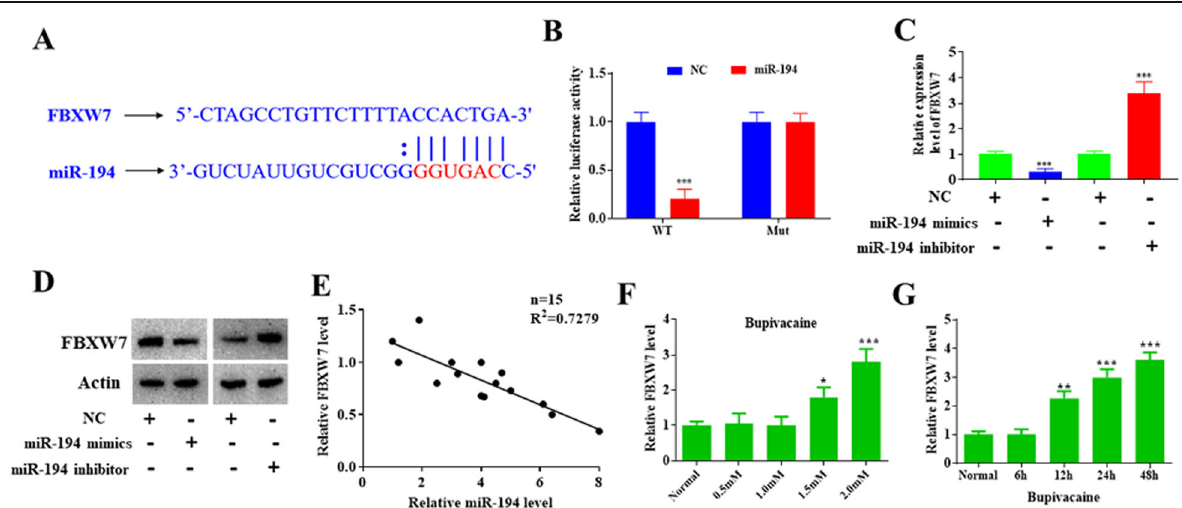
Fig. 4 FBXW7 is the direct target of miR-194. a The predicted binding sequence of the 3 ’ UTR of FBXW7 ’ s mRNA and miR-194. b The relative luciferase activity was significantly reduced in DRG neurons co-transfected with wt-lincRNA PADNA vector and miR-194 mimics than in DRG neurons co-transfected with mut-lincRNA PADNA vector or empty vector or mimic NC. c miR-194 negatively regulate the expression of FBXW7. d The expression of FBXW7 protein was significantly decreased in DRG neurons treated with miR-194 than in DRG neurons treated with mimic NC; while the expression of FBXW7 protein was significantly increased in DRG neurons treated miR-194 inhibitors than in DRG neurons treated with inhibitor NC. e RT-PCR revealed the expression of FBXW7 mRNA is negatively correlated with the expression of miR-194. f The expression of FBXW7 mRNA was significantly upregulated with the elevation of concentration of bupivacaine. g The expression of FBXW7 mRNA was significantly upregulated with the extension of bupivacaine treatment. Cells were treated with 1 mM bupivacaine and expression of FBXW7 was measured under different time points. Data are Mean ± SD with n = 3 independent biological cultures. * p < 0.05 and ** p <